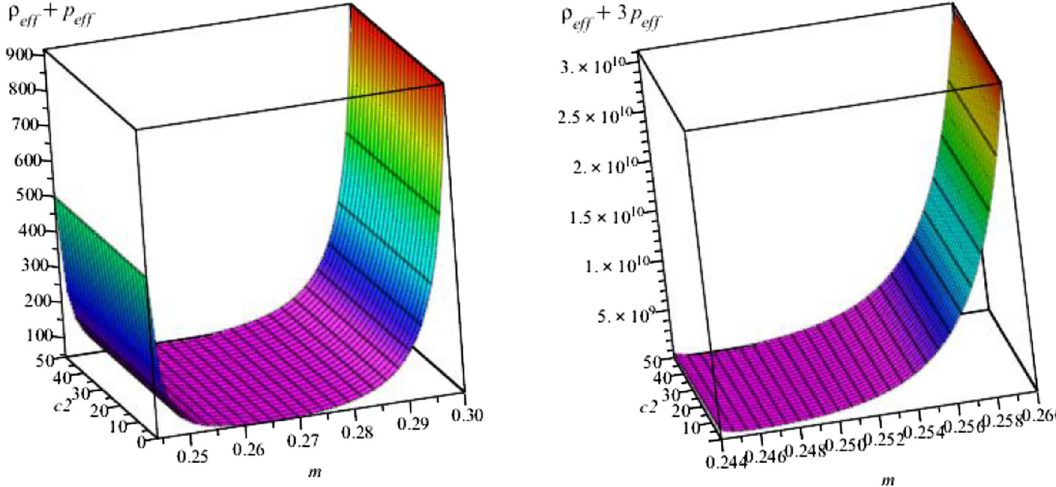
Fig. 2 The allowed range of parameter m for energy